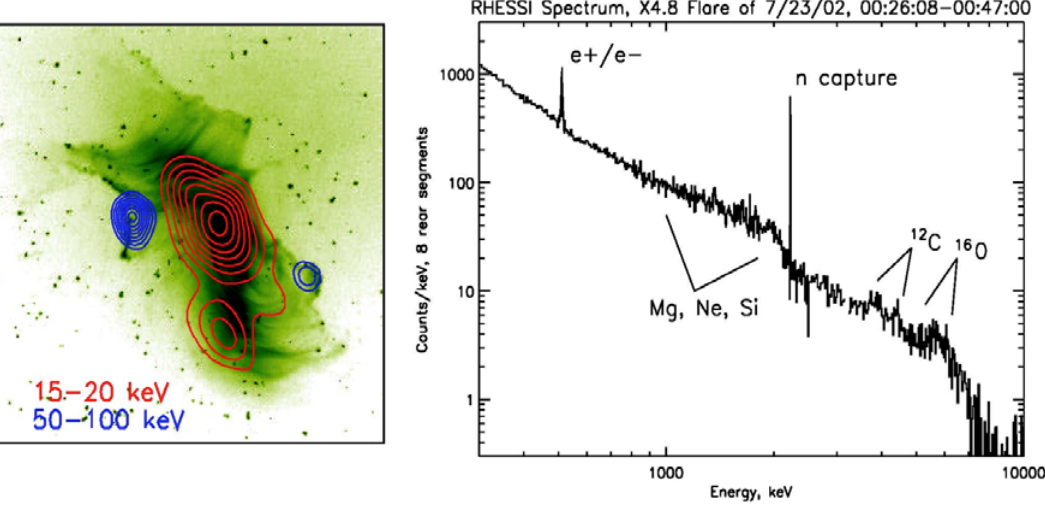
Figure 4. Left: An X-10 flare on 29 October 2003. The green image is a TRACE 195 Å filter image [29] that shows the flare arcade loops at high spatial resolution. Two RHESSI energy channels are also shown. The lower energy channel corresponds to the loop tops near the reconnection region while the higher energy is probably thick target Bremsstrahlung from the footpoints. Right: An X-ray/gamma-ray spectrum from a gamma-ray